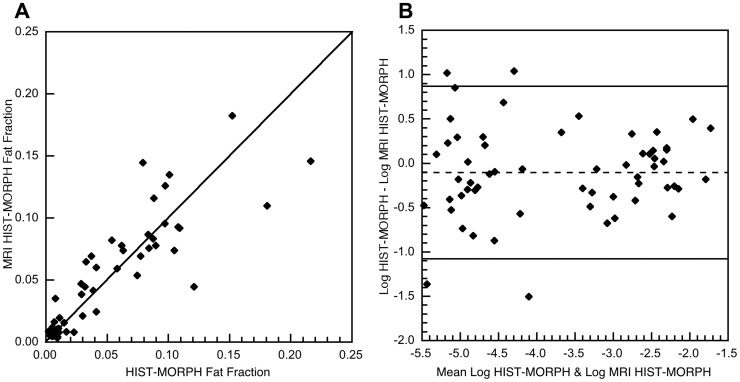
Limits of agreement between liver fat fraction measurements.A) MRI HIST-MORPH fat fraction plotted against HIST-MORPH fat fraction for the 59 subjects. The solid line is the line of equivalence. B) The difference between the natural logarithm of HIST-MORPH and the natural logarithm of MRI HIST-MORPH plotted against the mean of the two logarithms for the 59 subjects. The solid lines indicate the 95% limits of agreement and the dashed line is the mean difference between the logarithms of the two methods.